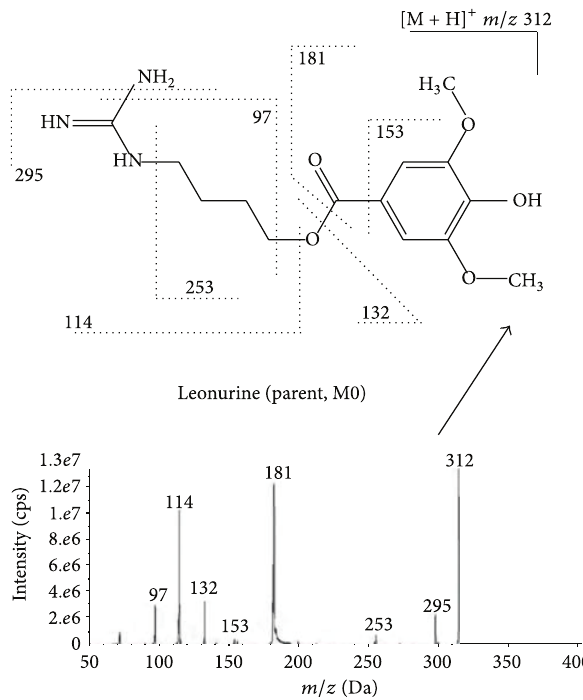
Figure 1: MS 2 spectra and fragmentation pattern of leonurine